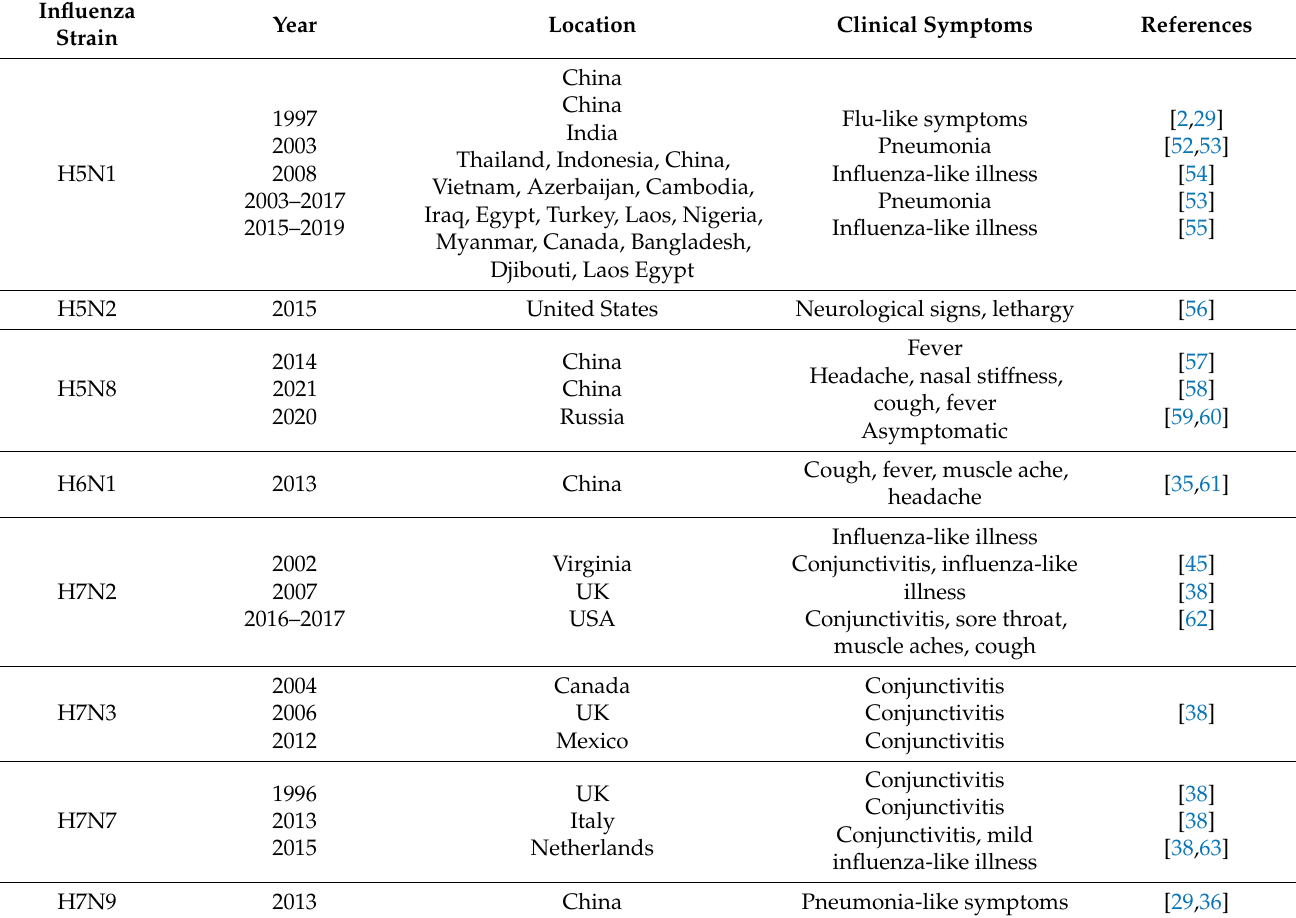
Table 1. Major avian influenza virus outbreaks that occurred in the past 30